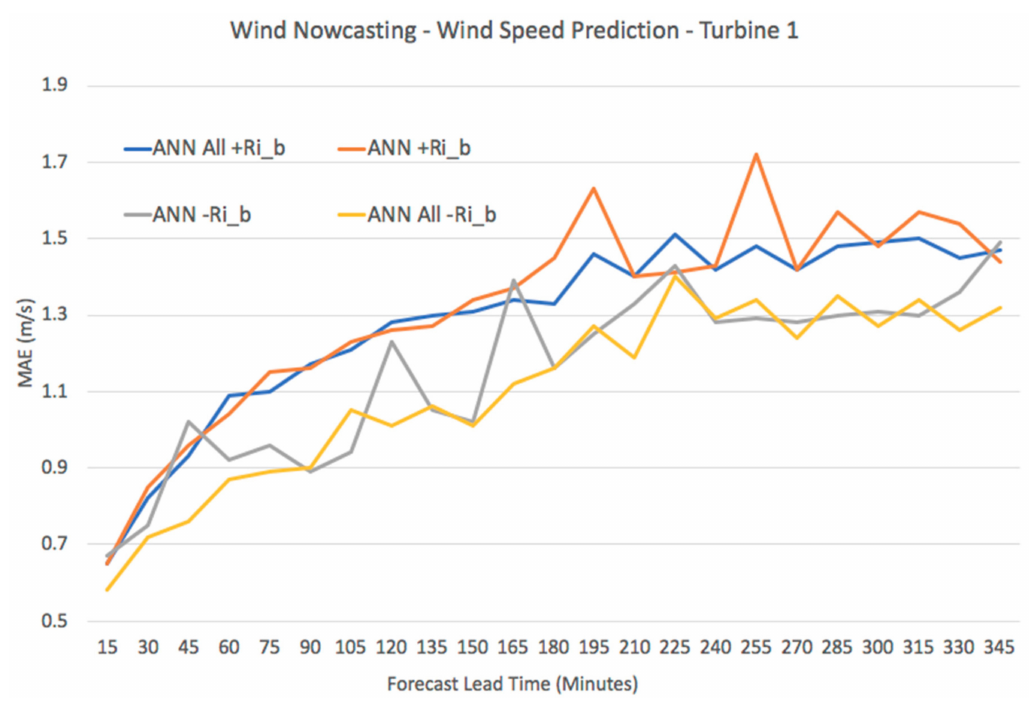
Figure 8. Results (MAE) for the ANN trained on all data and applied to each stability regime separately compared to the stability-regime dependent ANNs separated by unstable ( − ) and stable ( + ) regimes and applied to the same stability regime as the one trained